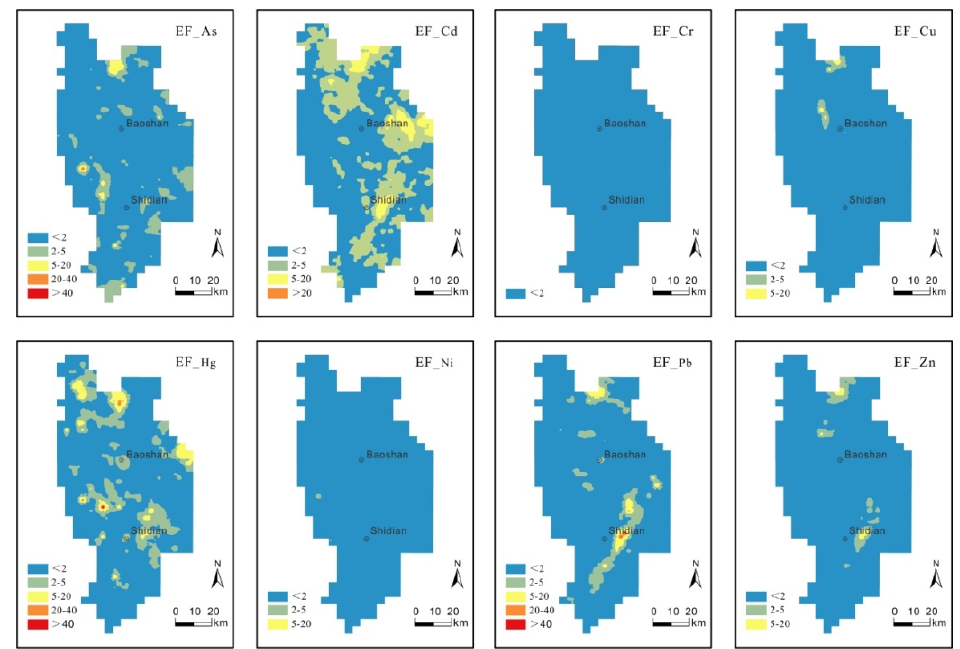
Figure 3. The distribution of counter maps of the enrichment factor (EF) determined by inverse distance-weighted (IDW)